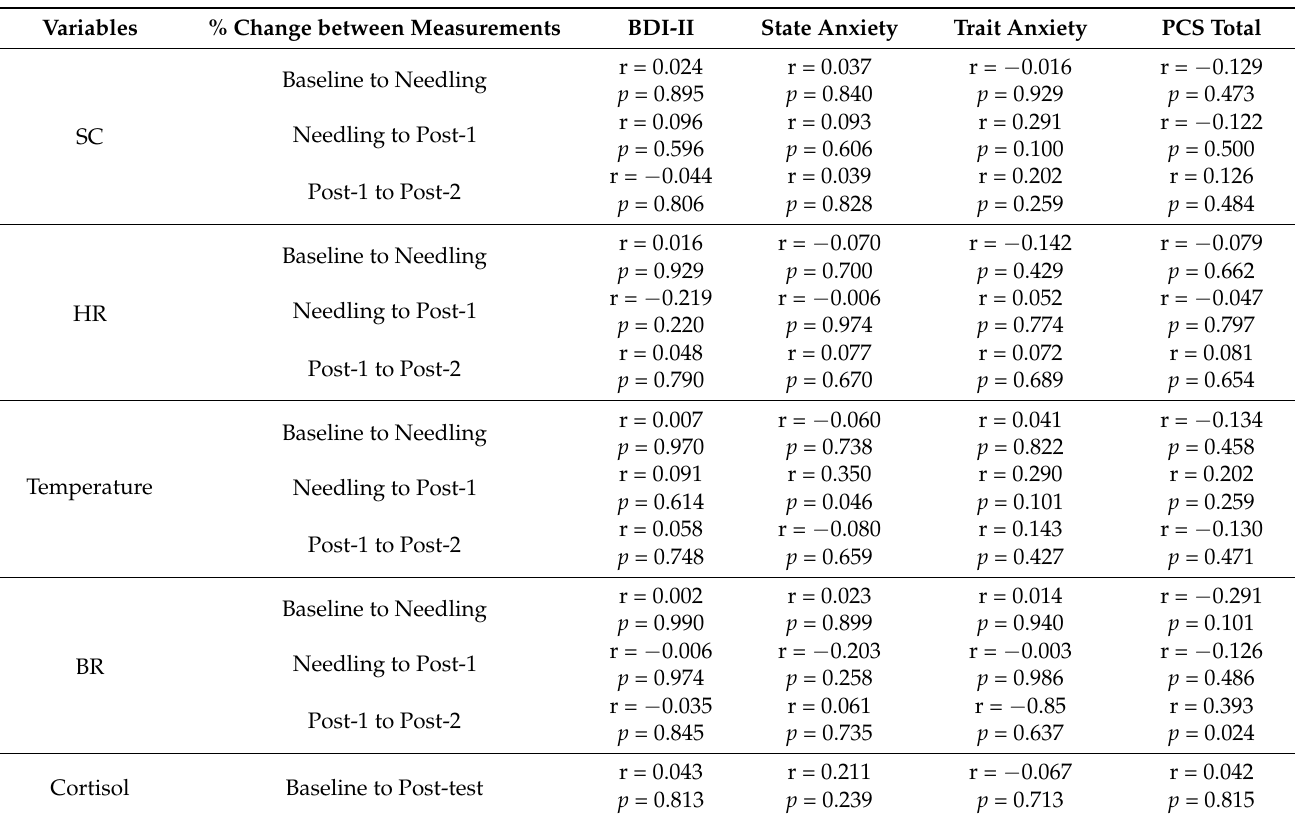
Table 5. Correlations between % Change of the Physiological Variables and Cortisol with Psychological Factors in the Dry Needling Group ( n =